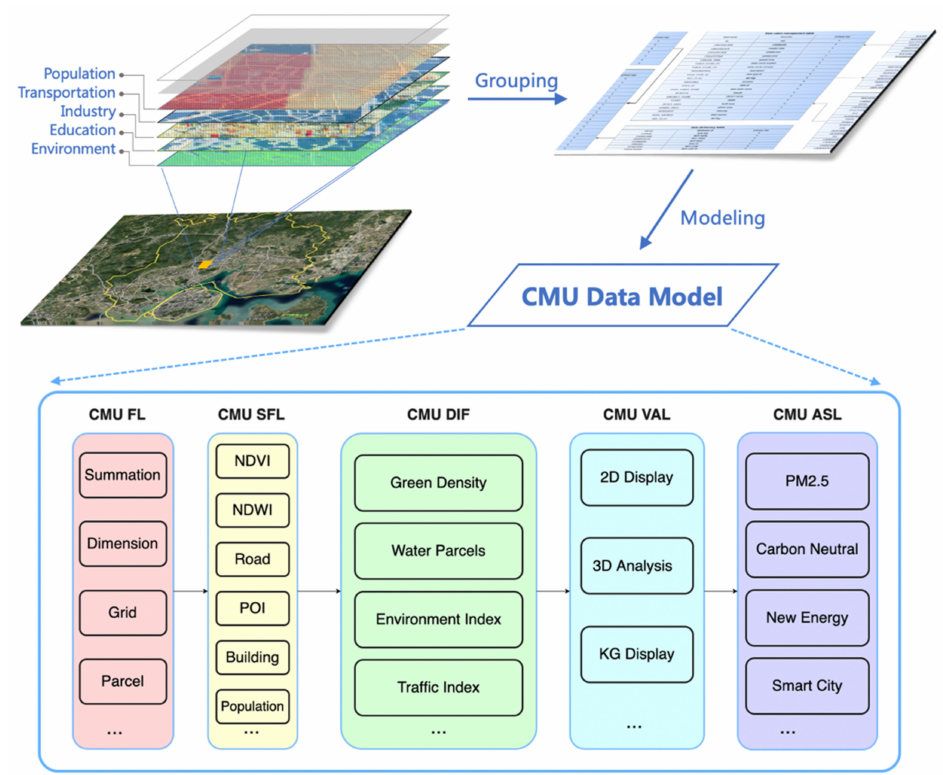
Figure 6. Diagram of CMU